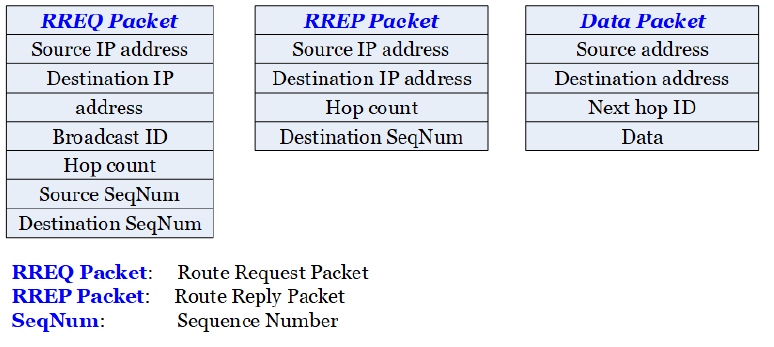
Figure 3. The packet structures used for clustering process.